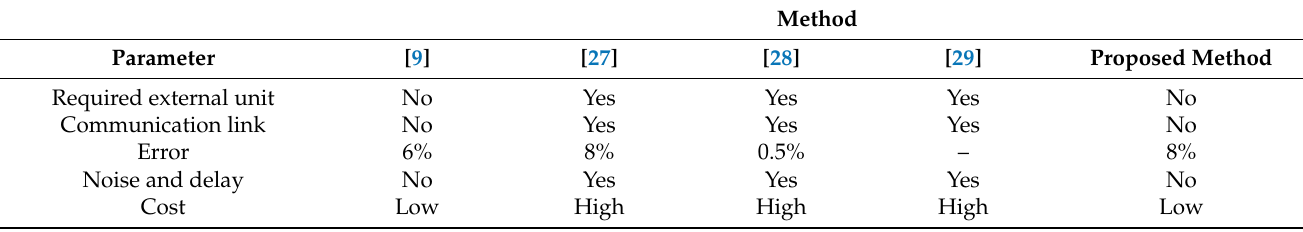
Table 3. Qualitative comparison of the proposed method with other existing